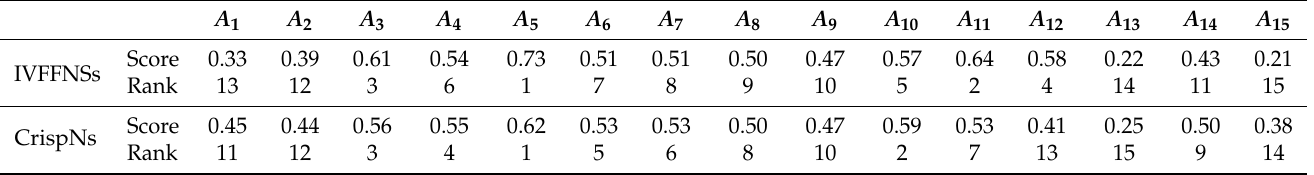
Table 4. Scores and their corresponding rankings—TOPSIS method, IVFFNs, and crisp